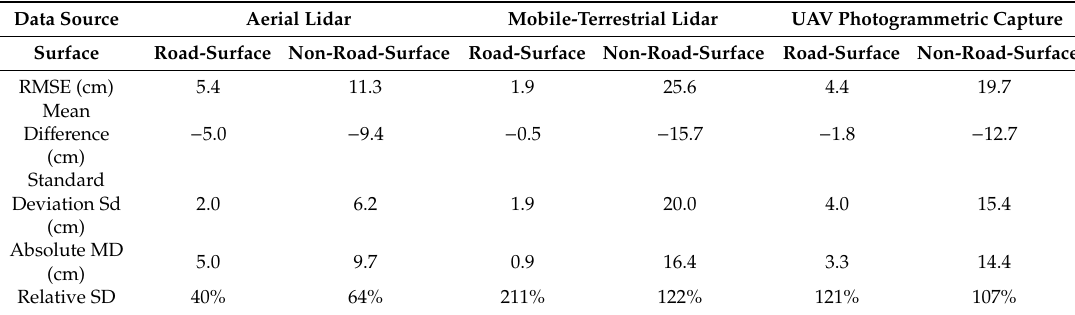
Table 4. Statistics Related to Di ff erence in Elevations for Road-Surface and Non-Road-Surface Survey